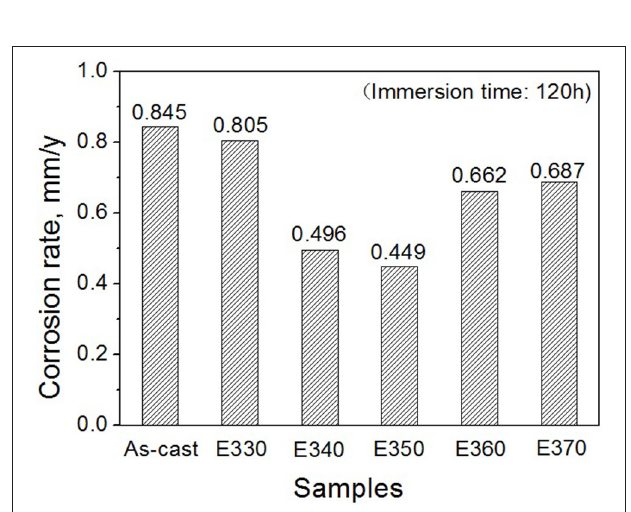
FIGURE 10 | Corrosion rates for Mg-2.0Zn-0.5Zr-3.0Gd alloy measured by weight loss after immersed for 120h.